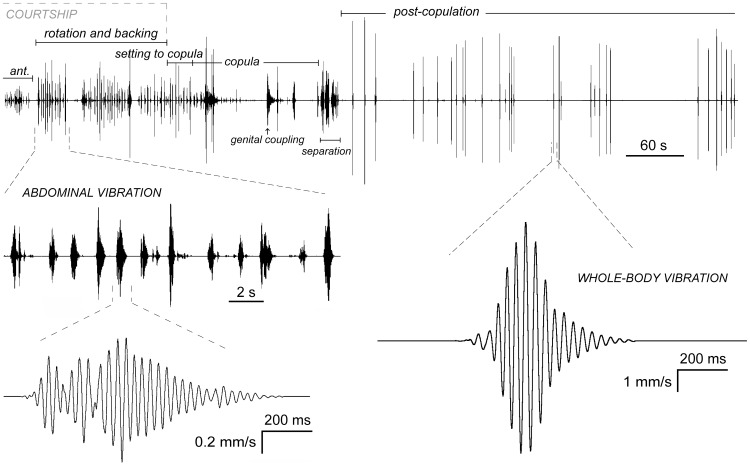
An example of audio recording (oscillograms) from elm bark conducted during and after mating in T. neglectus.Enlarged sections show abdominal vibration (left) and whole-body vibration signals (right). Antennation (ant.) and post-copulation phases are shown only partially (as indicated by the open line-end). Just after separation of the mates, recording sensitivity was decreased fivefold.